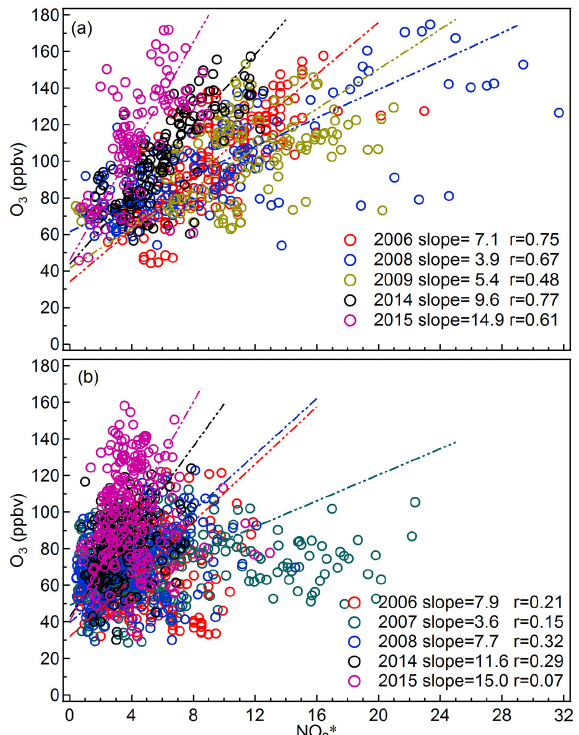
Figure 10. Monthly averaged NO ∗ Mt. Tai in (a) June and (b) July–August during 2006–2015. Error bars indicate the standard error of the mean. Note that the data point in June 2014 is for NO ∗ x instead of NO ∗